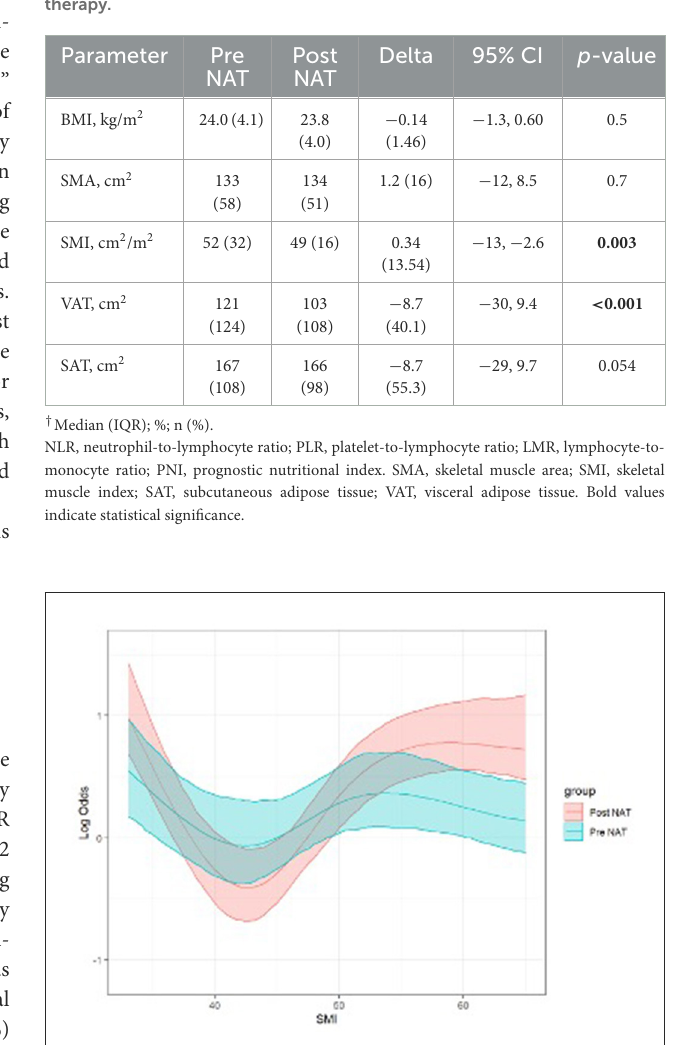
TABLE 2 Body composition parameters changes during neoadjuvant therapy.